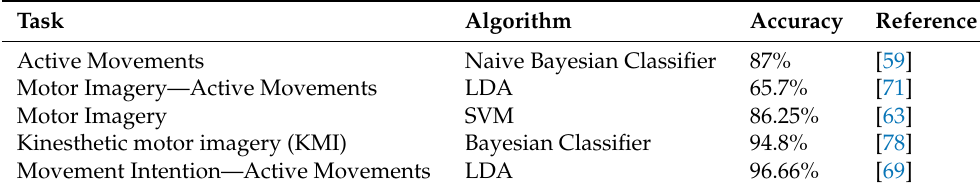
Table 3. Classification accuracy of the algorithms for each type of